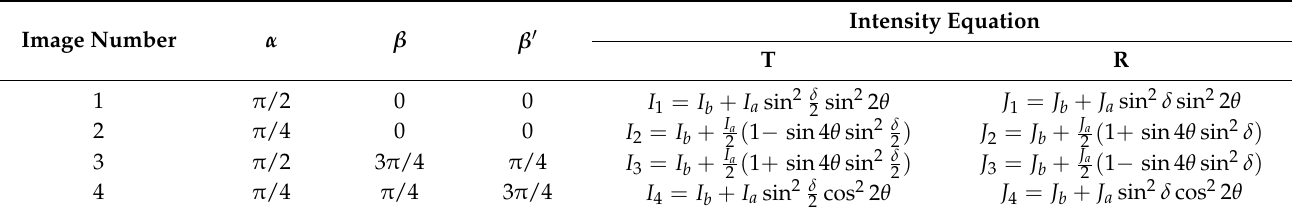
Table 1. The light intensity equations in the plane polariscope.